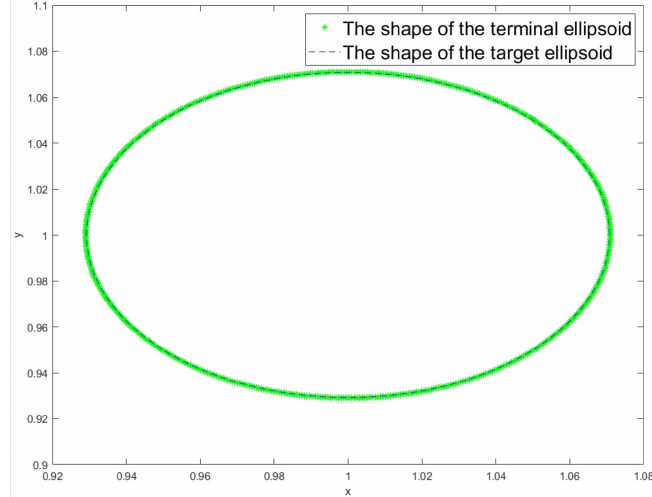
Figure 5. The comparison diagram of the configuration matrix of the terminal ellipse and the target